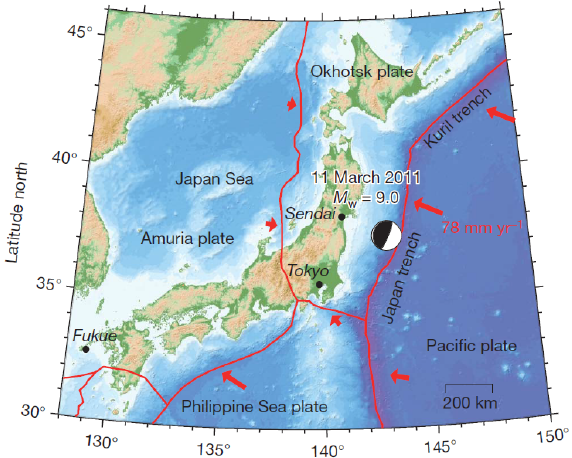
Figure 7. Plate configurations of the Japanese islands. The focal mech- anism of the Tohoku-Oki earthquake is taken from the Global Cen- troid-Moment-Tensor Project. The red arrows indicate relative motion between the two plates at a plate boundary [Ozawa et al.